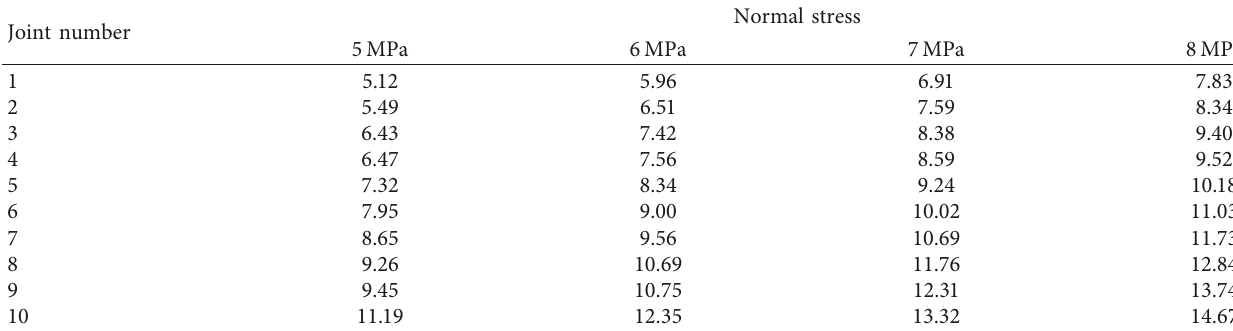
Table 6: τ LR values of joint simulated by the